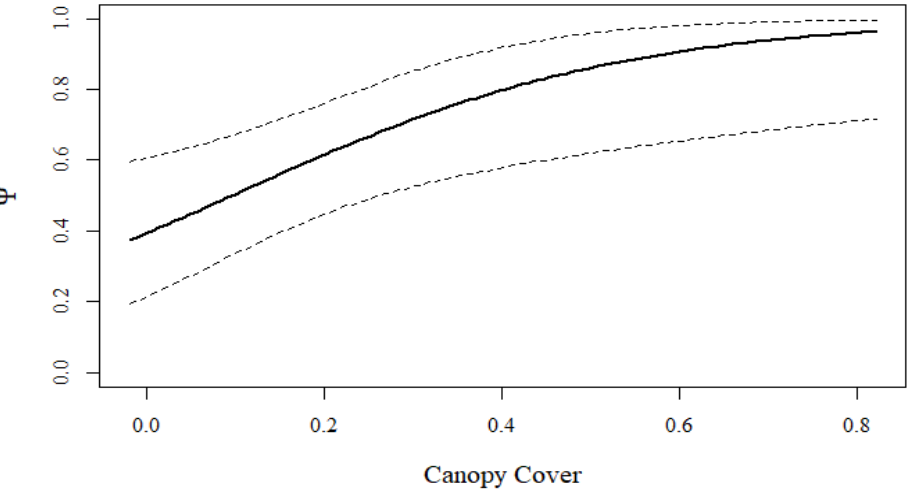
Figure 3. Probability of occupancy with increasing percent canopy cover in the area surrounding